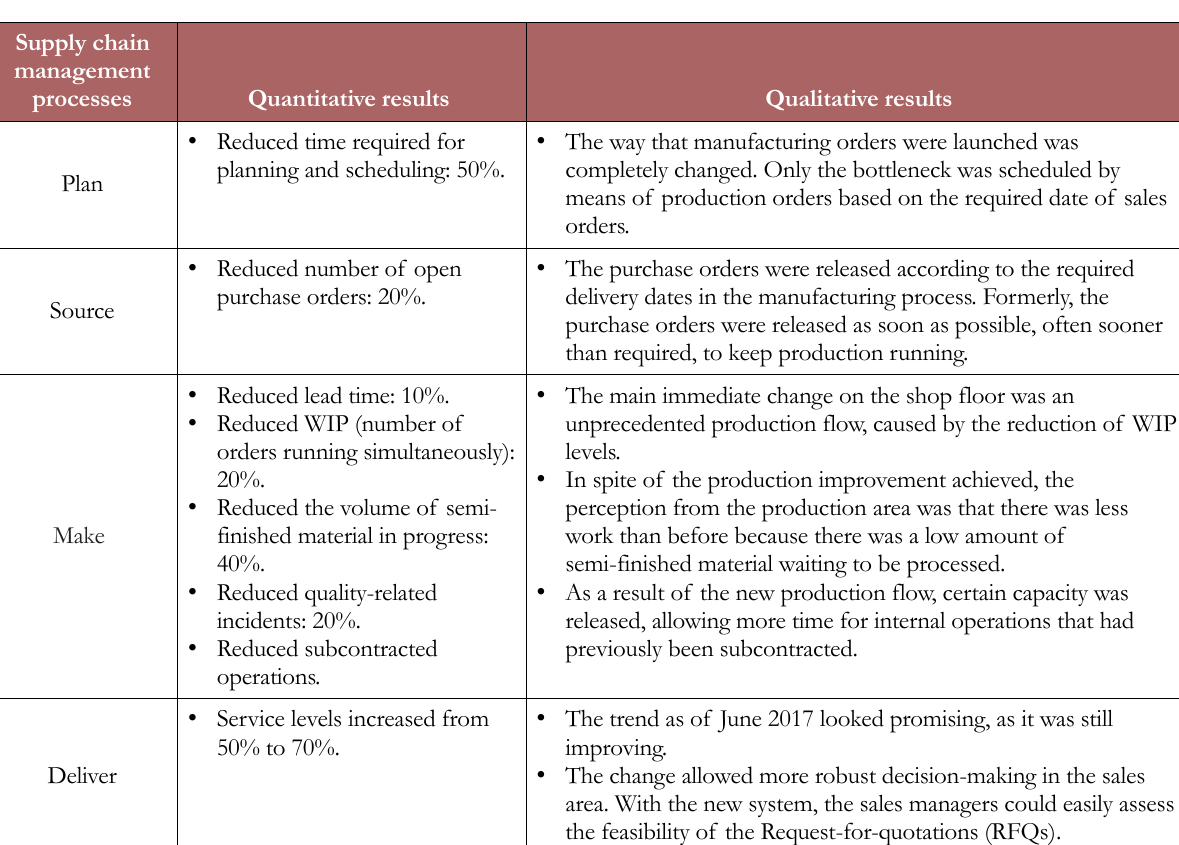
Table 8. Case study practical